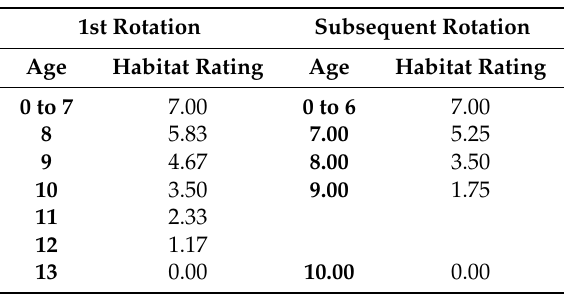
Table A6. Hen harrier suitability scores of forest land-use.